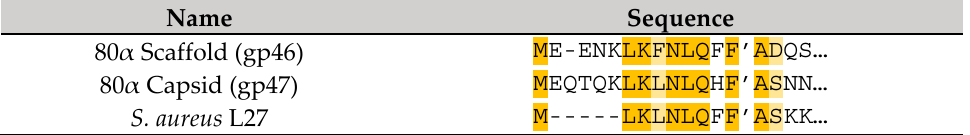
Table 1. The amino acid sequence present in Staphylococcal phage 80 α aligned with the sequence of L27 in S. aureus .